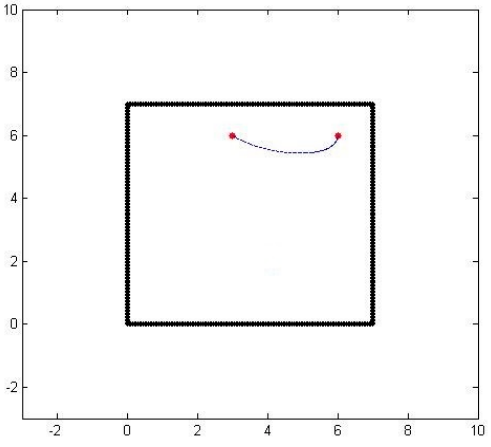
Figure 2. An air-borne particle path with matching terminal velocities.